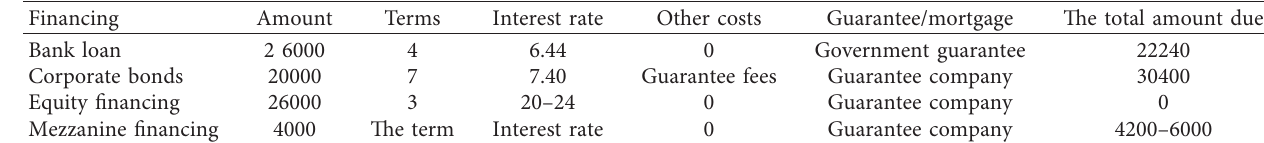
Table 1: Financing structure of smart city infrastructure construction